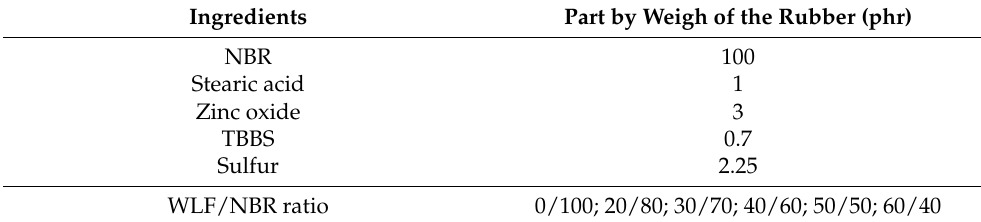
Table 1. The technical parameters for waste leather fiber (WLF)/ nitrile butadiene rubber (NBR) composition. Ingredients Part by Weigh of the Rubber (phr) NBR 100 Stearic acid